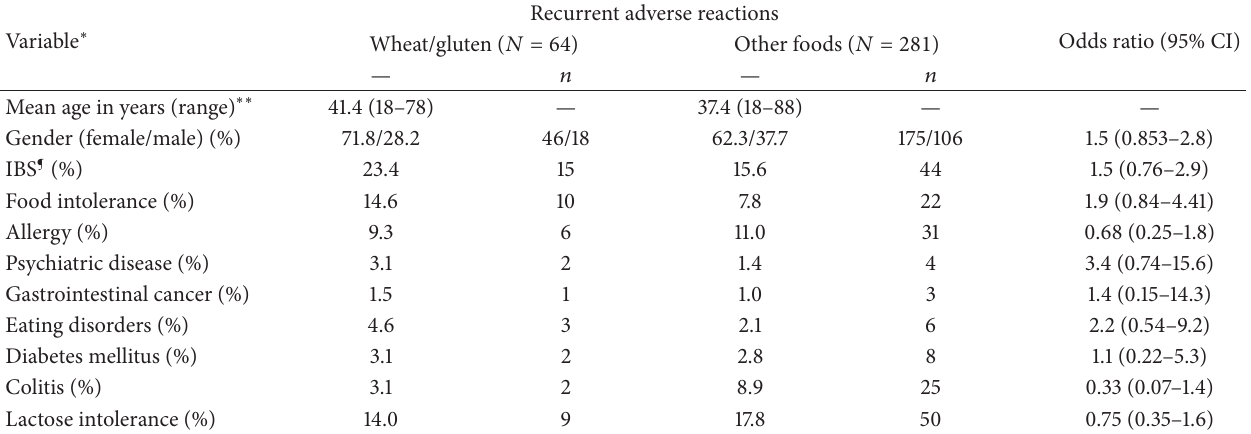
Table 2: Comparison between self-reported recurrent adverse reactions to wheat/gluten and recurrent adverse reactions to other foods.